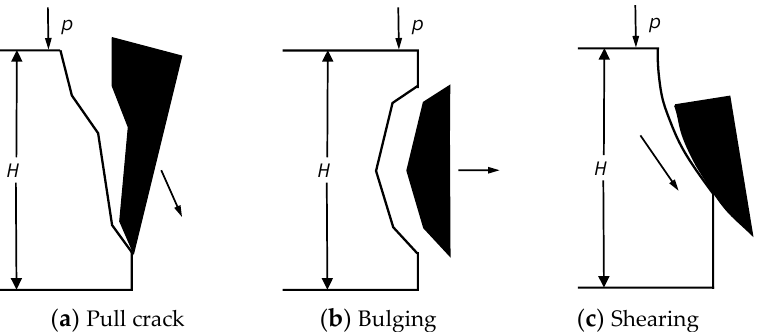
P -top plate presure,